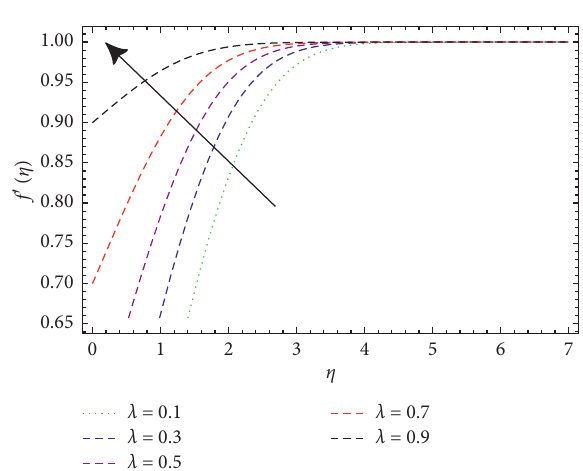
Figure 8: Influence of the velocity f ′ ( η ) profile via λ